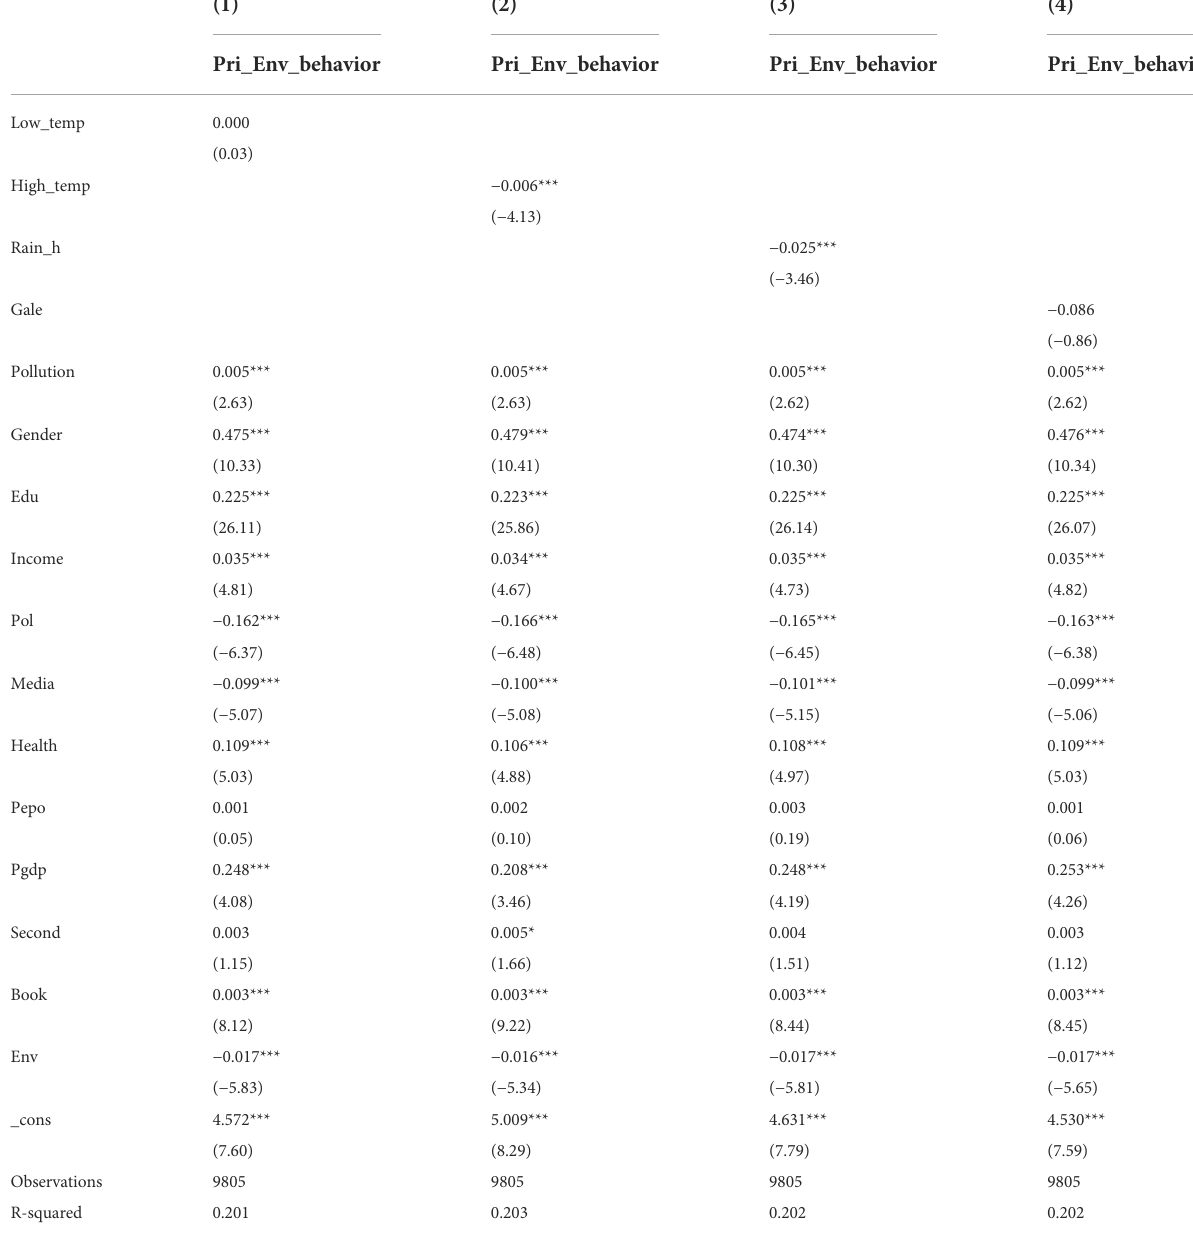
TABLE 7 Replacement of weather indicators